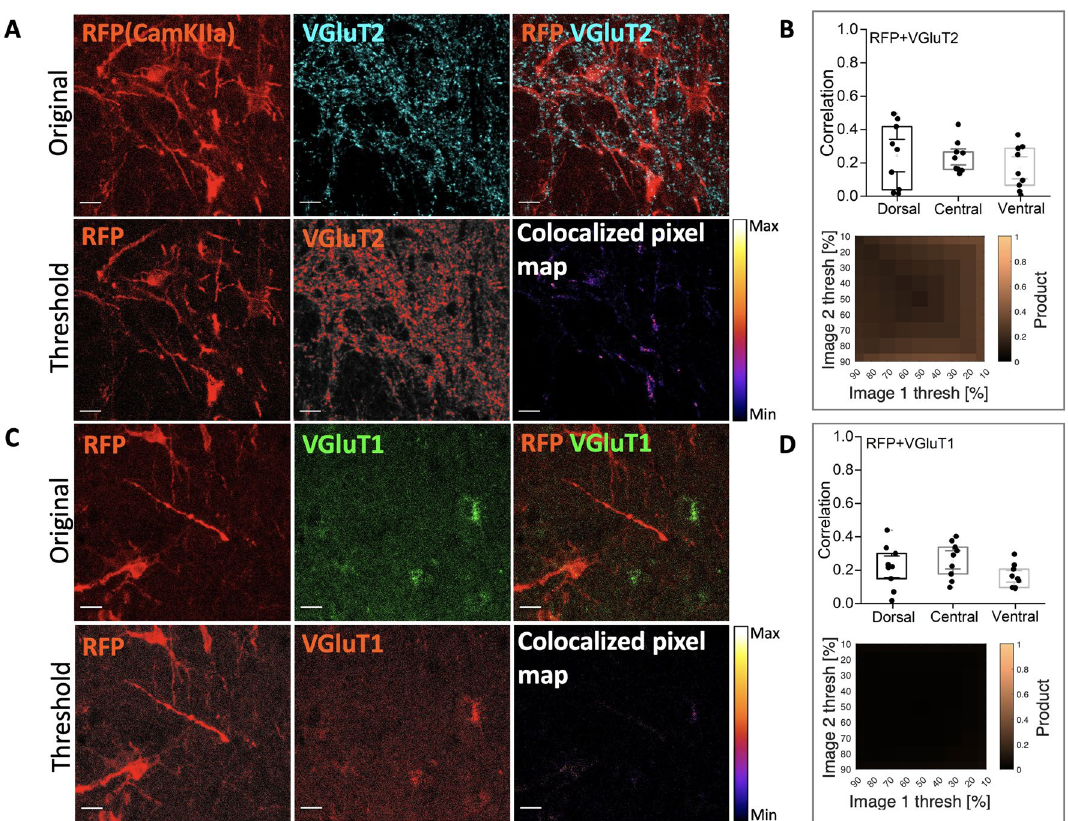
Figure 5. AAV9-CamKIIa has little or no colocalization with VGluT2 and VGluT1 staining. ( A ) Top row: the infected cells with the CamKIIa promoter (AAV9) express mScarlet (RFP) and its overlap with VGluT2 (cyan), and second row: thresholded views of the top row and the heat map of RFP and VGluT2. ( B ) Top right grey box: fluorescent correlation plots of RFP and VGluT2 show very little co-expression. ( C ) First row: original images showing mScarlet (RFP), VGluT1 (green) and their overlap, and bottom row: the threshold views of the images and and the heat map for co-localization. ( D ) Bottom right grey box: the correlation for various levels of threshold appear dark. (N = 3 animals, n = 3–4 sections/animal). Scale bar 20 µ